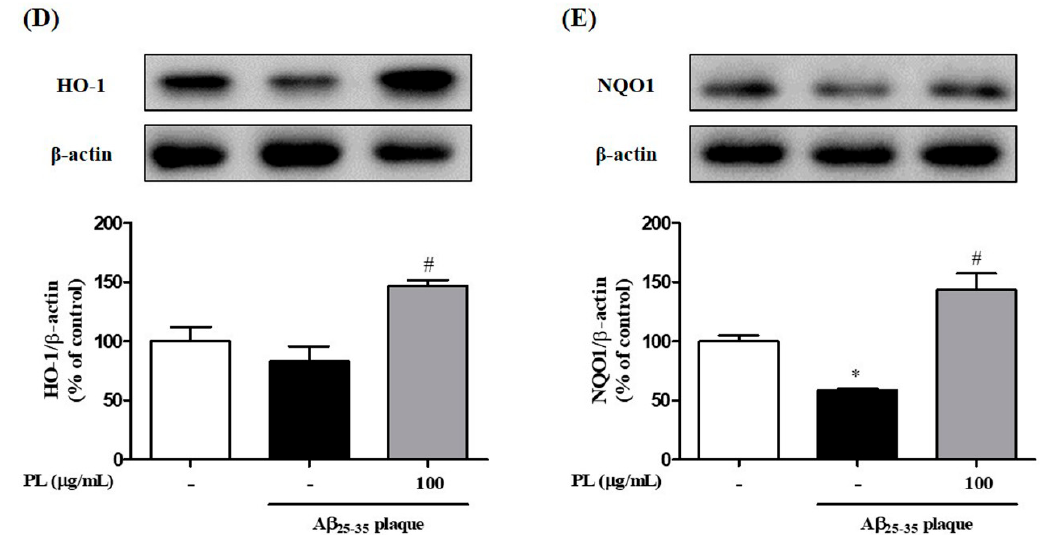
Figure 4. Inhibitory effect of PL on intracellular reactive oxygen species (ROS) generation induced by A β 25–35 plaque in HT22 cells. Cells were treated with PL (10 and 100 μ g/mL) for 1 h and incubated with A β (10 μ mol/L) for a further 23 h. ( A ) ROS generation was measured by fluorescence intensity of 2’,7’-dichlorofluorescin (DCF) 24 h after PL treatment and is presented as percentage of control. Cell lysates were assessed by qRT-PCR and Western blot using heme oxygenase-1 (HO-1) and NAD(P)H quinine dehydrogenase 1 (NQO1) antibodies. ( B – E ) Quantification of ( B ) mRNA and ( D ) protein of HO-1 and ( C ) mRNA and ( E ) protein of NQO1. The data were normalized to GAPDH or β -actin. Values are mean ± standard error of the mean. * p < 0.05 and *** p < 0.001 vs. control group; # p < 0.05, ## p < 0.01 and ### p < 0.001 vs. A β 25–35 plaque group.